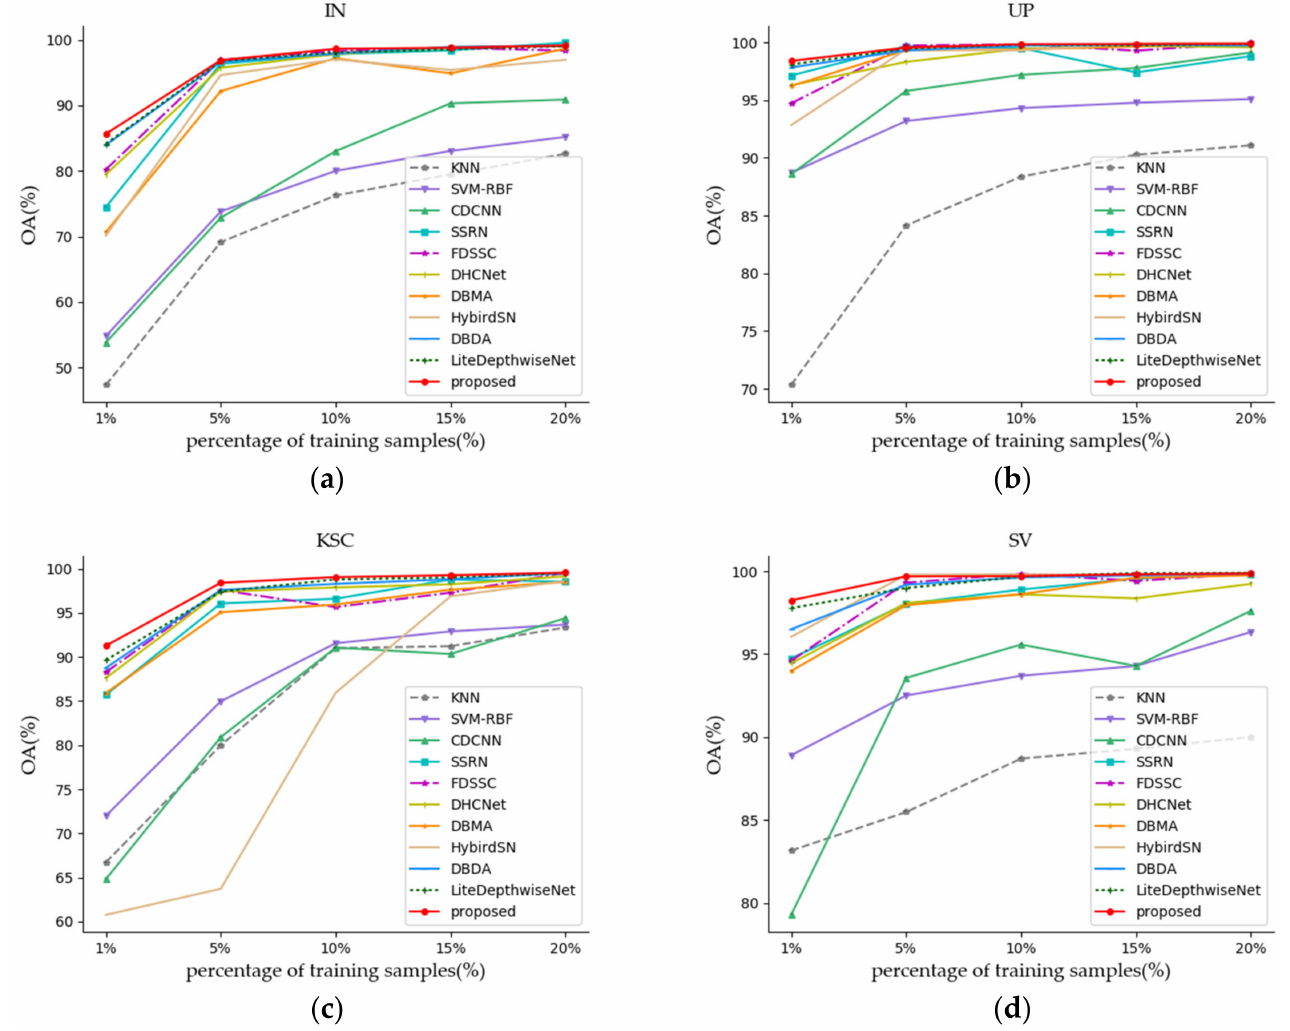
Figure 12. Classification results (OA%) with different amounts of training samples on four datasets. ( a ) IN. ( b ) UP. ( c ) KSC. ( d )